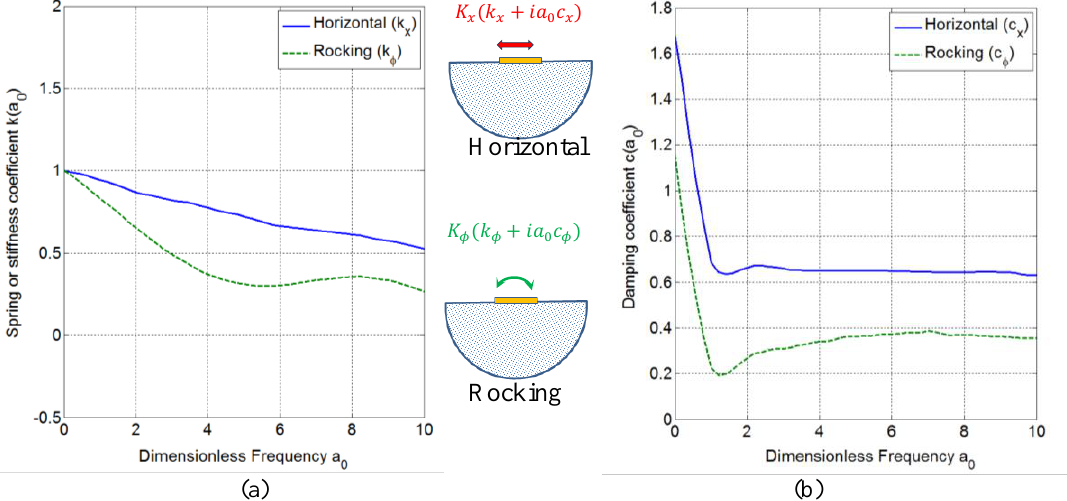
Figure 7. (a) and (b) Dynamic stiffness coefficients of rigid disk on half-space: spring &